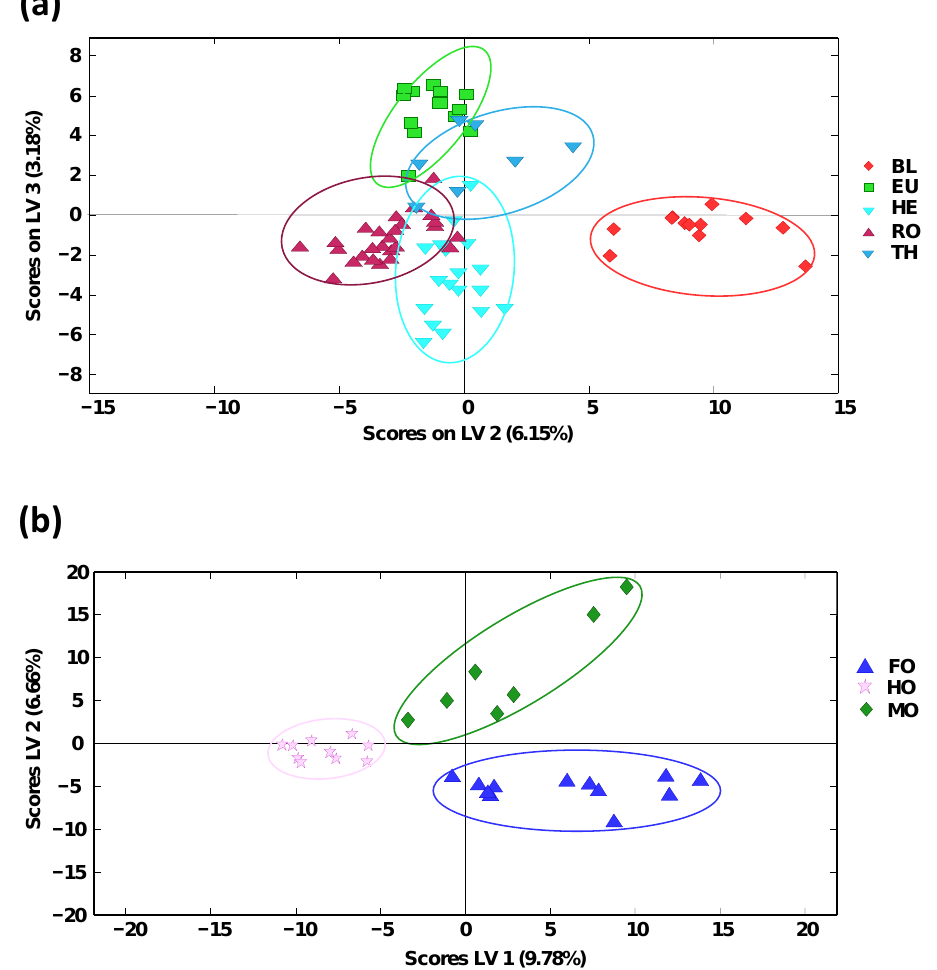
Figure 4. Partial least squares-discriminant analysis (PLS-DA) score plots when using off-line SPE HPLC-LRMS fingerprints as honey chemical descriptors for the classification of ( a ) honey-blossom botanical varieties (LV2 vs. LV3 score plot, 4 LVs were used to build the model) and ( b ) honeydew-honey botanical varieties (LV1 vs. LV2 score plot, 3 LVs were used to build the model). BL: Orange/lemon blossom; EU: Eucalyptus; FO: Forest; HE: Heather; HO: Holm oak; MO: Mountain; RO: Rosemary; TH: Thyme.